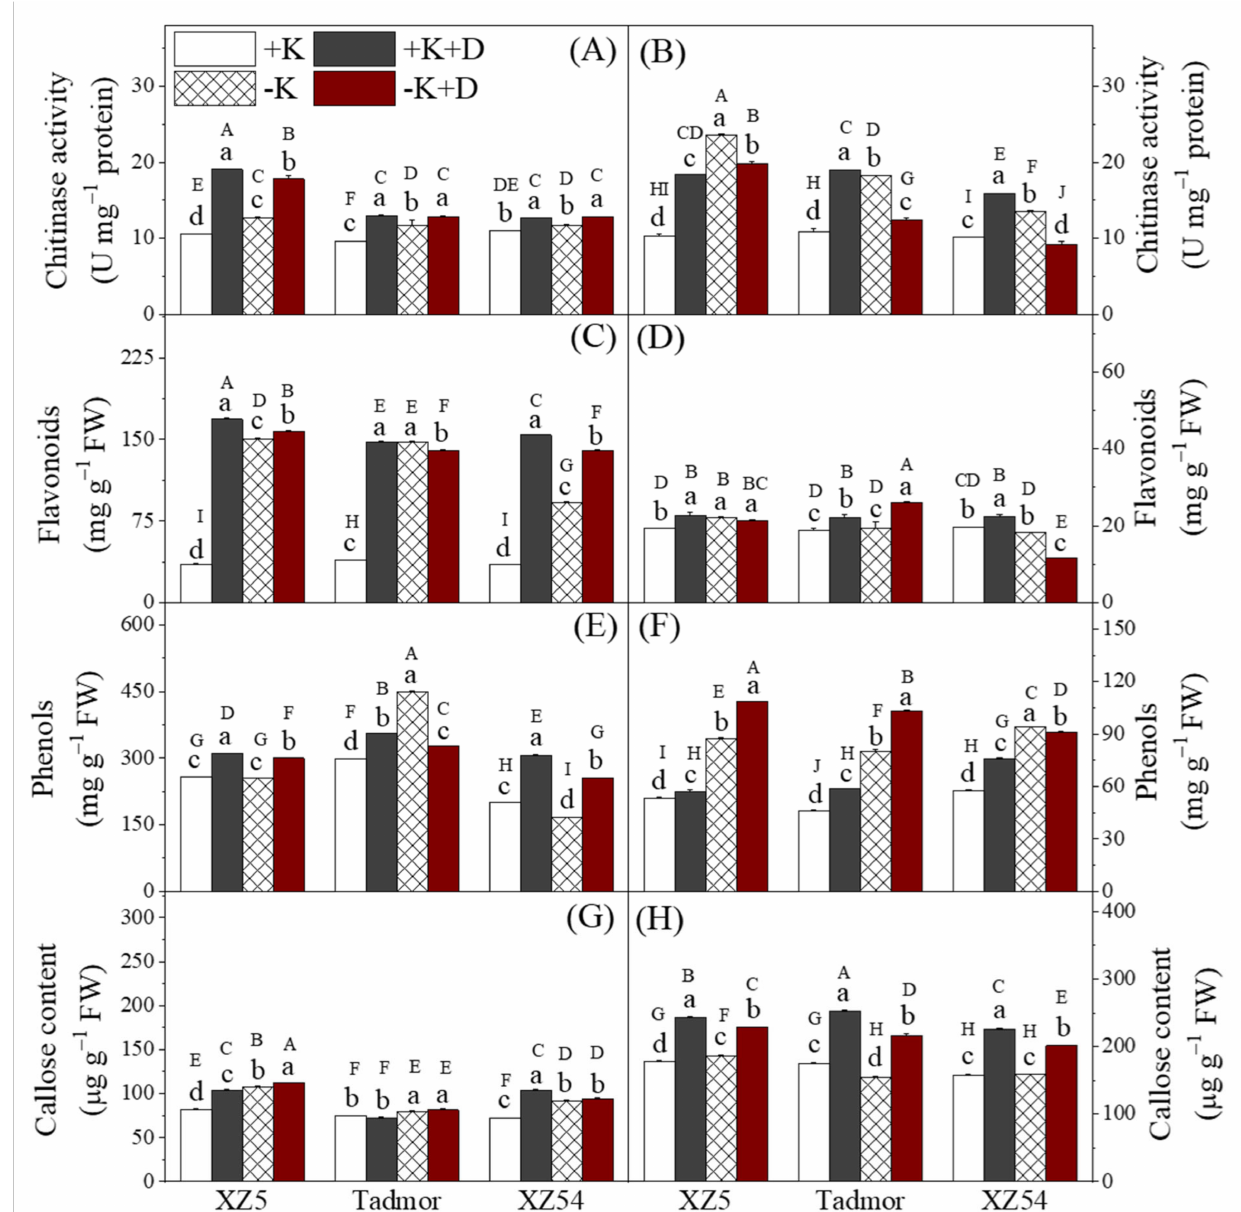
Figure 4. Effect of alone and combined stress of drought and K deprivation on secondary metabolites callose, phenol, flavonoids and chitinase activity in leaves ( A , C , E , G ) and roots ( B , D , F , H ) of three barley genotypes. Different capital and small letter(s) indicate significant differences ( p <0.05) among the genotypes and among the 4 treatments within each genotype, respectively. +K, +K+D, –K, and –K+D, correspond to basic nutrition solution with normal K of 1 mM K (BNS), BNS + 20% polyethylene glycol 6000 (PEG), BNS without K (K deprivation), and BNS without K + PEG, respectively. Error bars represent standard deviations ( n =